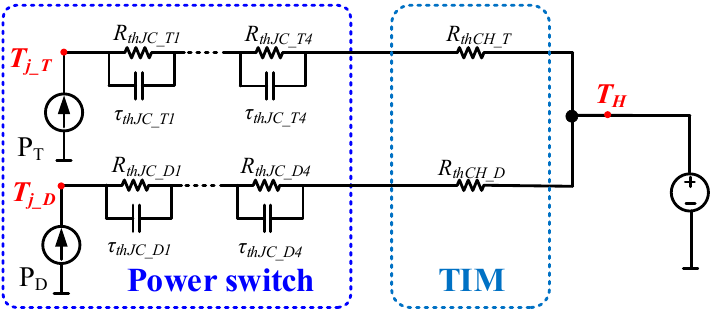
Figure 4. Thermal model of power semiconductor for thermal cycling caused by the fundamental frequency.